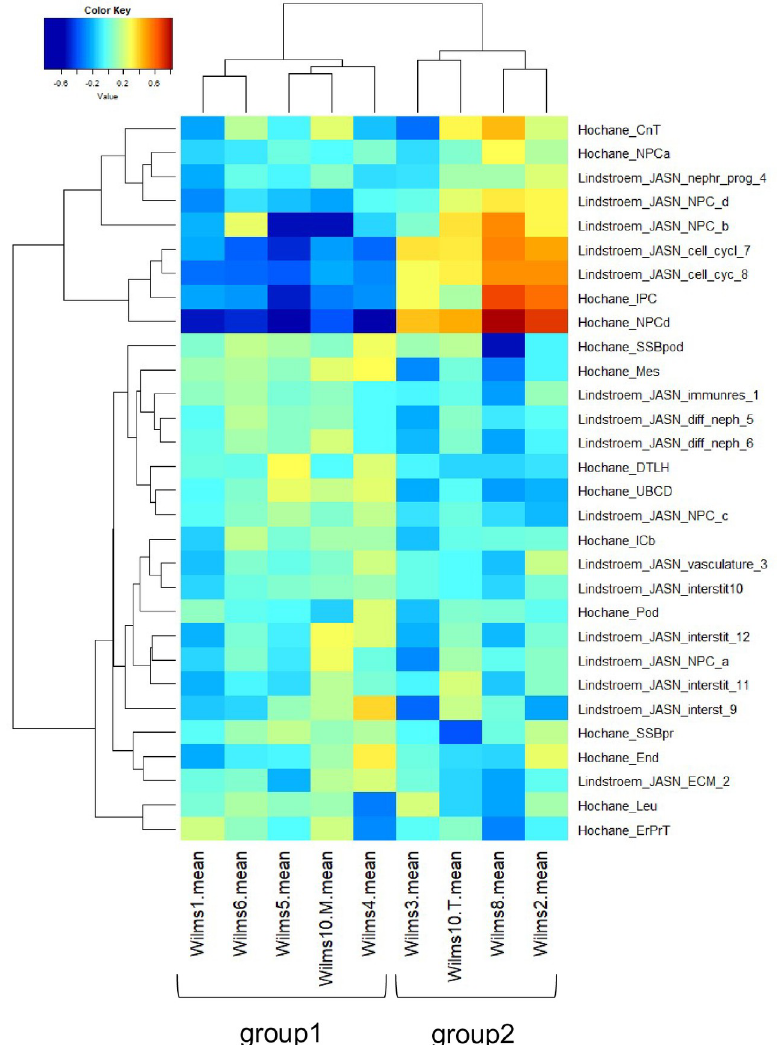
Fig 9. GSVA enrichment scores for the Hochane and Lindstro¨m clusters in Wilms cells. Expression values of Wilms tumor samples were subjected to GSVA analysis using gene sets associated with developmental kidney cell types in the single cell sequencing studies [32, 43]. In the hierarchical cluster analysis of the GSVA enrichment scores two main clusters of samples emerged: group1 (Wilms Tumor samples 1, 4, 5, 6 and 10M) had higher enrichment in differentiated and lower enrichment in nephron progenitor cell (NPC)-like cells; group2 (Wilms Tumor samples 2, 3, 8 and 10T) had lower enrichment in differentiated and higher enrichment in NPC-like